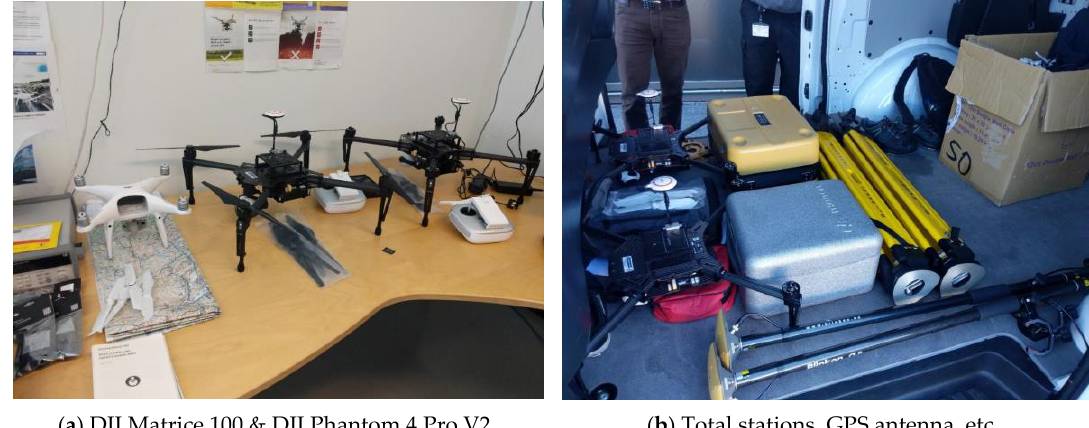
Figure 3. Tools and equipment used during drone-assisted inspection.